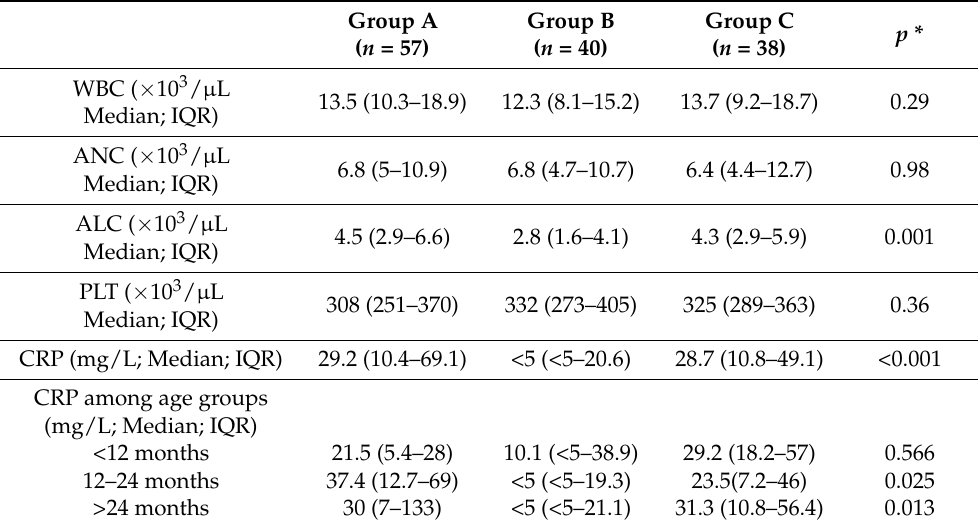
Table 3. The characteristics of laboratory values in patient groups.